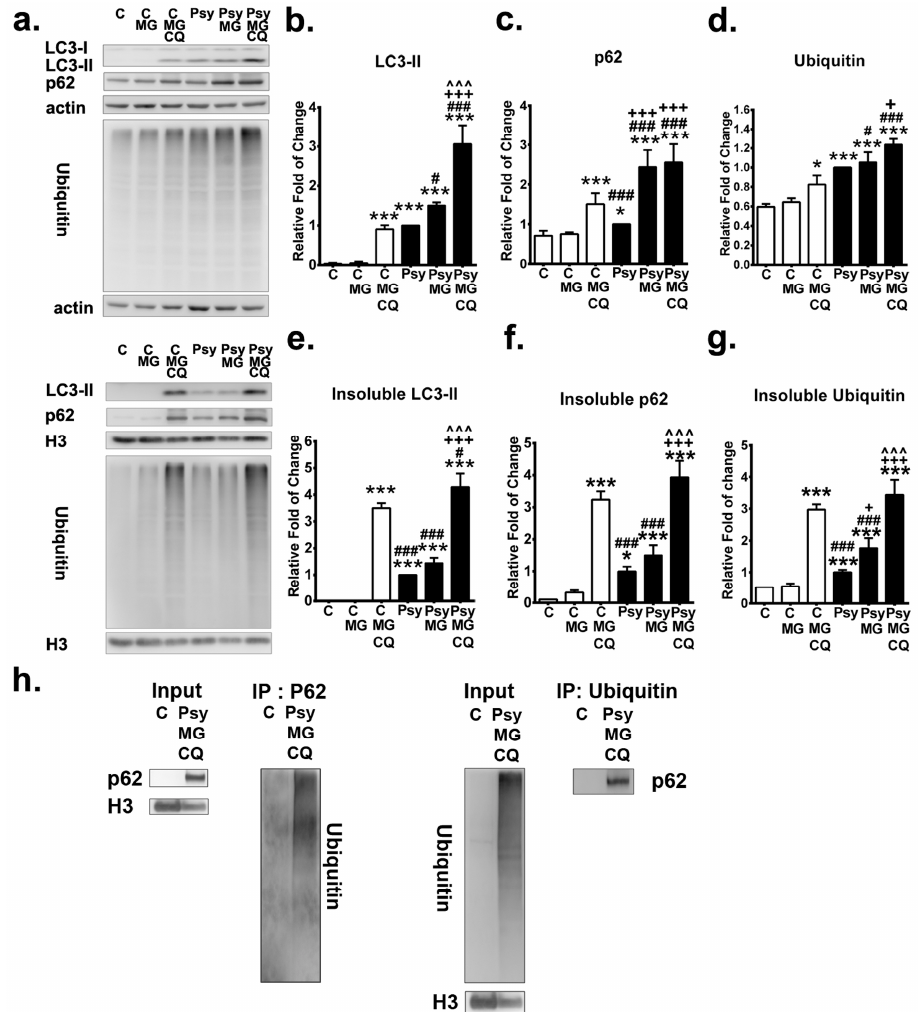
Figure 10. Inhibition of autophagy and proteasome exacerbates accumulation of p62 and ubiquitin. ( a ) Western blot analysis of the total LC3-II, p62, and ubiquitin in MO3.13 cells treated without (control: C) / with psychosine (Psy) for 72 h concomitant with / without MG132 (MG) with / without chloroquine (CQ) for the last 24 h. Soluble and insoluble fractions were analyzed. β -actin (actin) and histon-H3 (H3) were used for the loading control in soluble and insoluble fractions, respectively. ( b , c , d ) Quantification of soluble LC3-II ( b ), p62 ( c )and ubiquitin ( d ). ( e , f , g) Quantification of